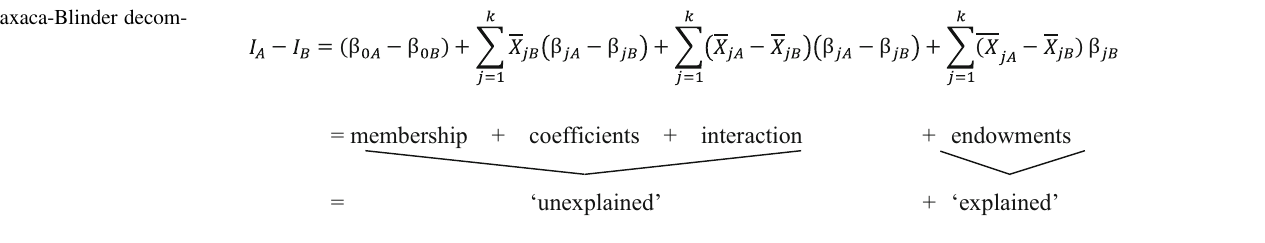
Fig. 3 Oaxaca-Blinder decom- position